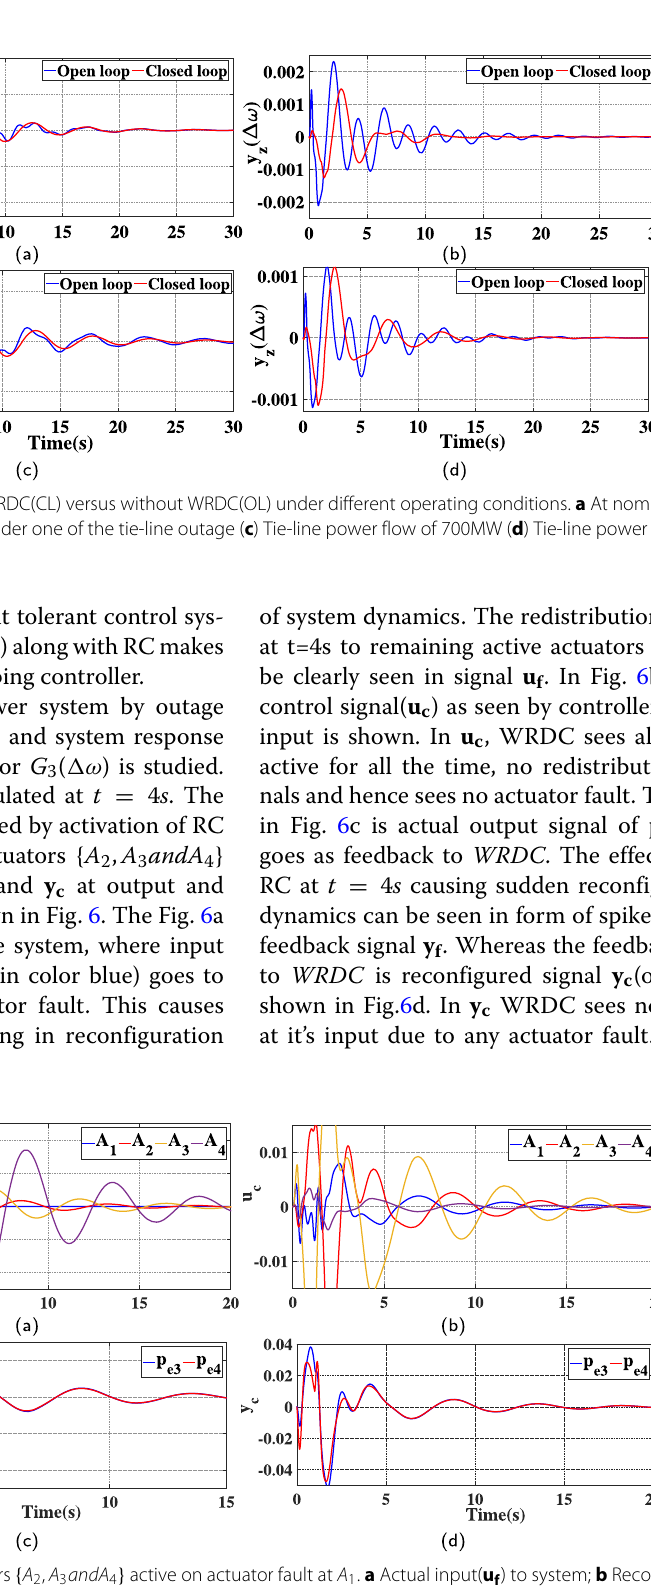
Fig. 6 System reconfiguration with actuators { A 2 , A 3 andA 4 } active on actuator fault at A 1 . a Actual input( u f ) to system; b Reconfigured control signal( u c ) as seen by controller at system input; c Actual feedback signal( y f ) showing effect of integration of RC at time of fault ; d Reconfigured feedback signal(